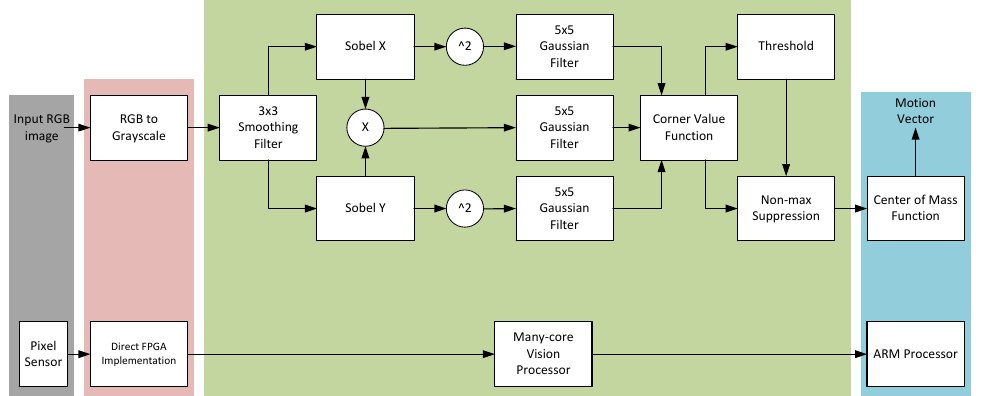
Figure 8. Motion estimation using a corner detector.